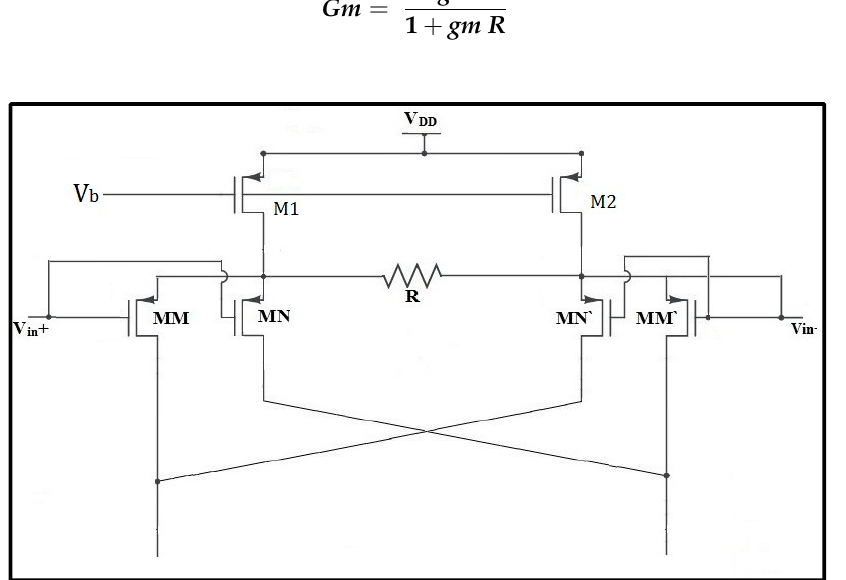
Figure 1. Cross coupled differential pair with source degeneration.